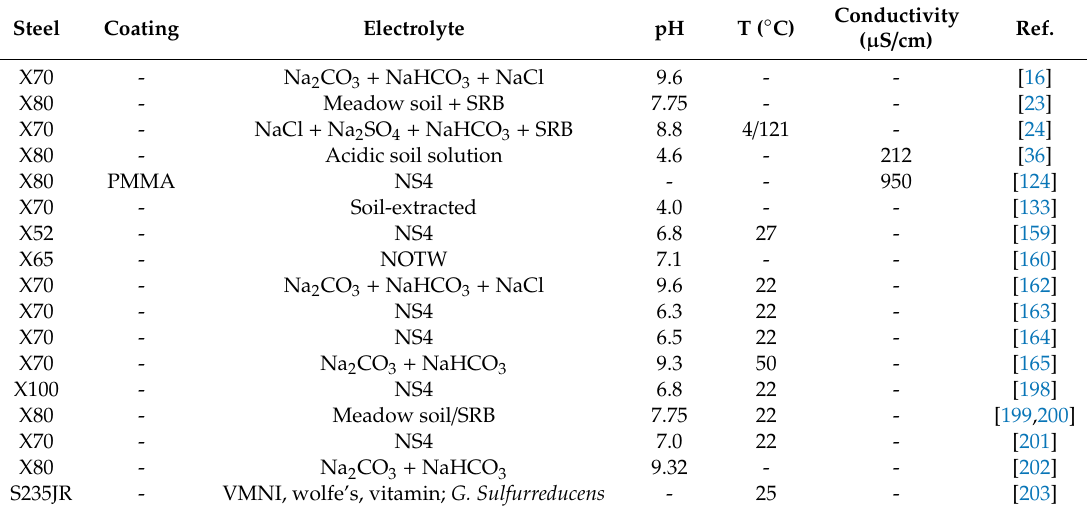
Table 3. Continued reviewed physicochemical properties for external corrosion